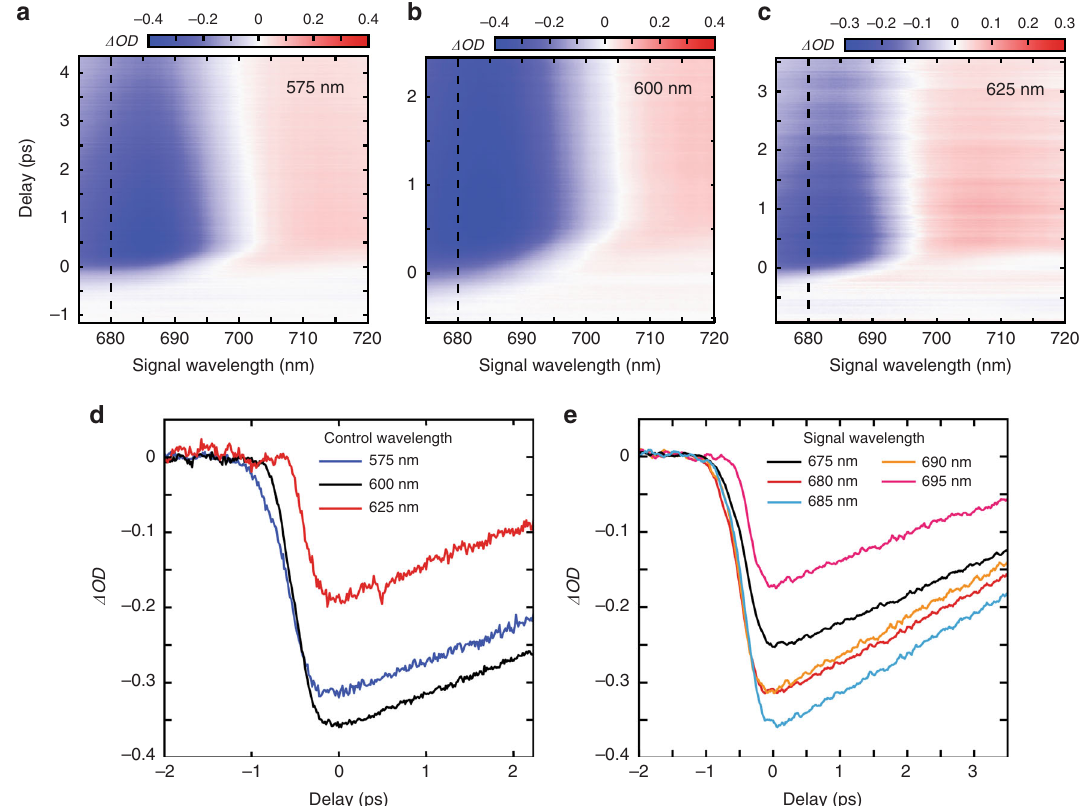
Fig. 5 Effect of changing control and signal light wavelength on transient optical properties. Transient dynamics spectra for different control light wavelengths of a 575 nm, b 600 nm and c 625 nm. The sample is illuminated at an angle of 45° using a ×4 objective. The peak power density for each pump wavelength was set around 10 GWcm − 2 with pulse duration around 70 fs for each wavelength. d Measured Δ OD at a signal wavelength of 680 nm, indicated by the dashed line in a – c , for different control wavelengths. e Measured Δ OD at different signal wavelengths for a control wavelength of 575 nm. In e and d , zero delay is taken to be the point at which the value of | Δ OD | is maximum